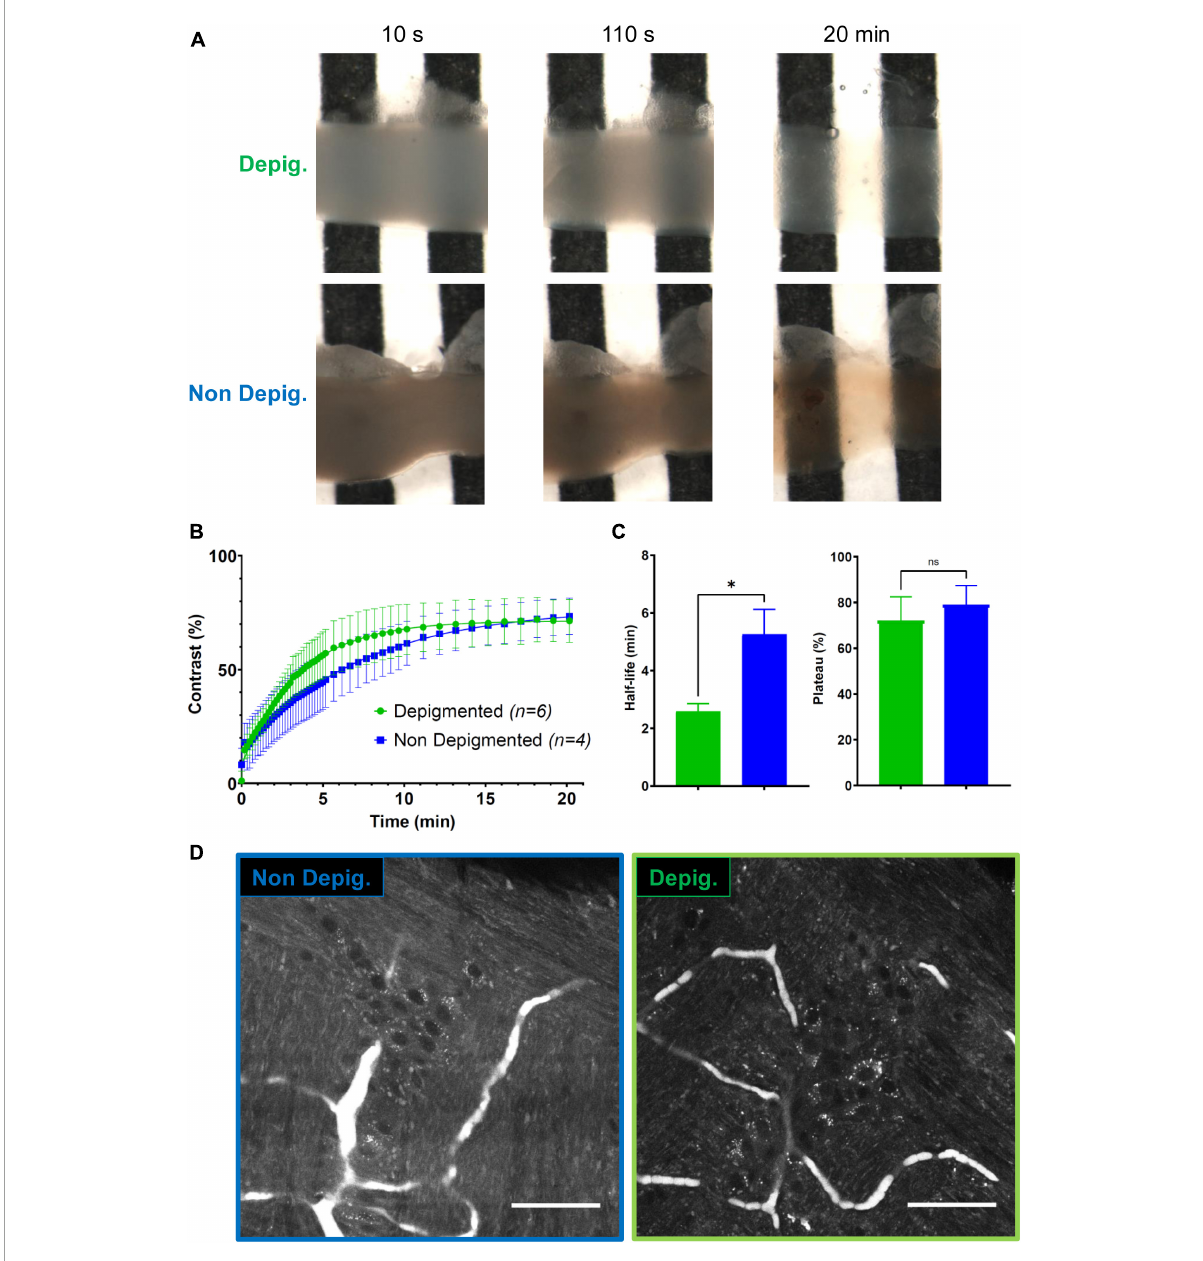
FIGURE2 Fast clearing of the small intestine. (A) Longitudinal sections of ileum observed at various delays after the addition the clearing reagent (10 s, 110 s, 20 min) on a black and white pattern with (top) or without (bottom) a depigmentation step. (B) Quantification of the constrast ( C M ) enhancement under depigmented (green) and non-depigmented (blue) conditions. (C) Half-life (left) and yield (efficiency) of the clearing protocol (right) under depigmented (green) and non-depigmented (blue) conditions. (D) Autofluorescence (AF) imaging at the level of the Auerbach’s plexus upon 405 nm excitation in non-depigmented (left) and depigmented (right) conditions. Scale-bar: 50 µ m. Error-bars show SD. ∗ , p < 0.05, Mann–Whitney test; ns, non-significant.